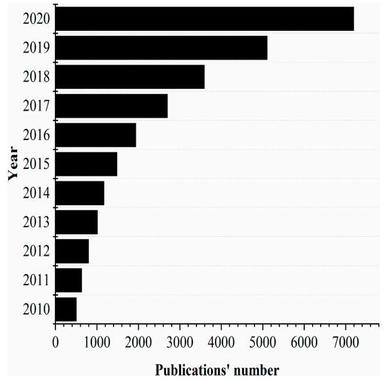
The number of MOF-related publications from 210 to 2020 (data was extracted from ScienceDirect website by searching the keyword "metalorganic framework").